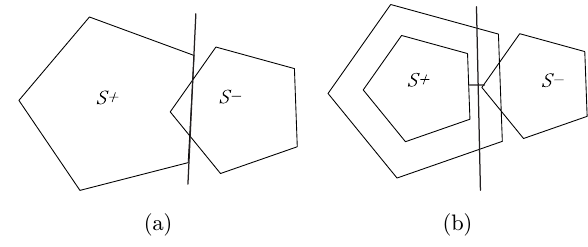
Fig. 3. The SCHs for class imbalance problem.